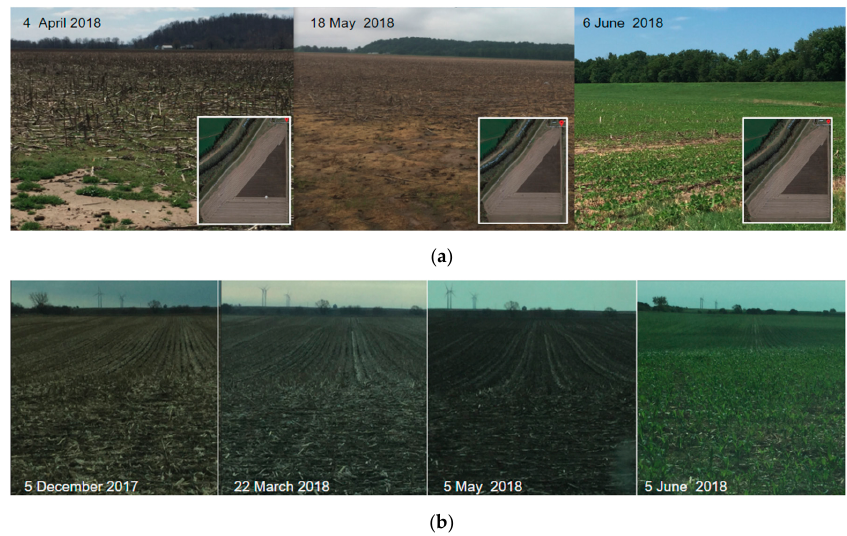
Figure 4. ( a ) Roadside photos taken of field ID-57-448 in Missouri observed from 4 / 4 / 2018 to 6 / 6 / 2018. The crop observed for 2017 is corn, 2017-2018 winter shows evidence of cover crop type that was not identifiable by the data collector, and 2018 crop is soybean; ( b ) Roadside photos for field ID-70-443 in Iowa observed from 12 / 5 / 2017 to 6 / 5 / 2018. The 2017 crop was corn, 2017-2018 winter shows no cover crop, 2018 crop was